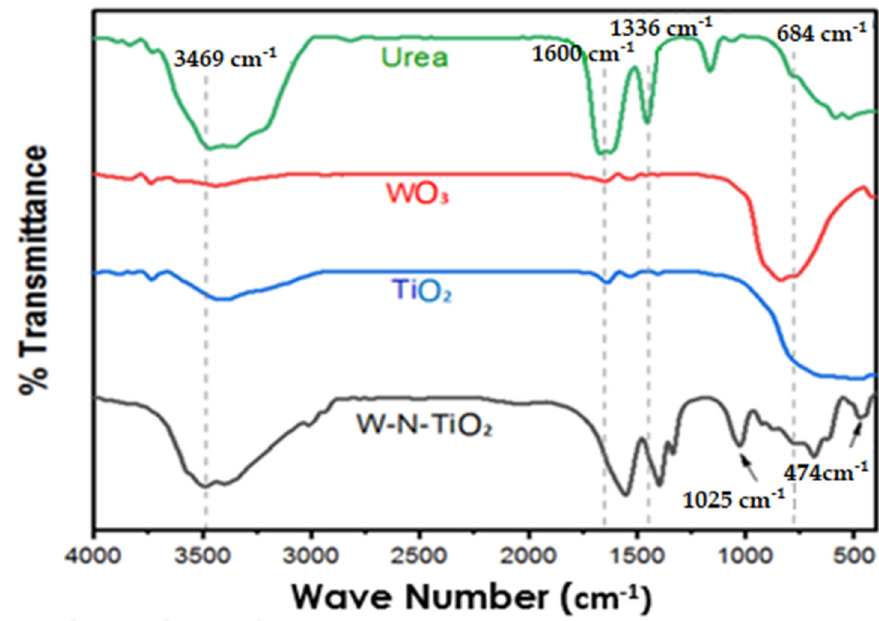
Figure 4. FTIR spectra of urea, WO 3 , TiO 2, and tungsten-nitrogen co-doped TiO 2.